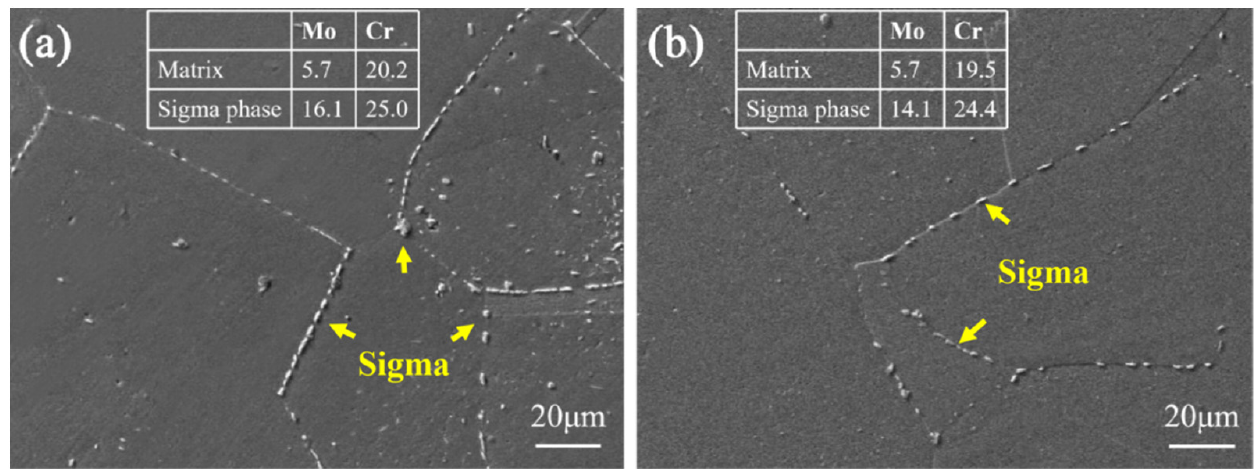
Figure 1. SEM morphologies of 254SMO–0B ( a ) and 254SMO–40B ( b ) samples aged at 1000 °C for 30min.